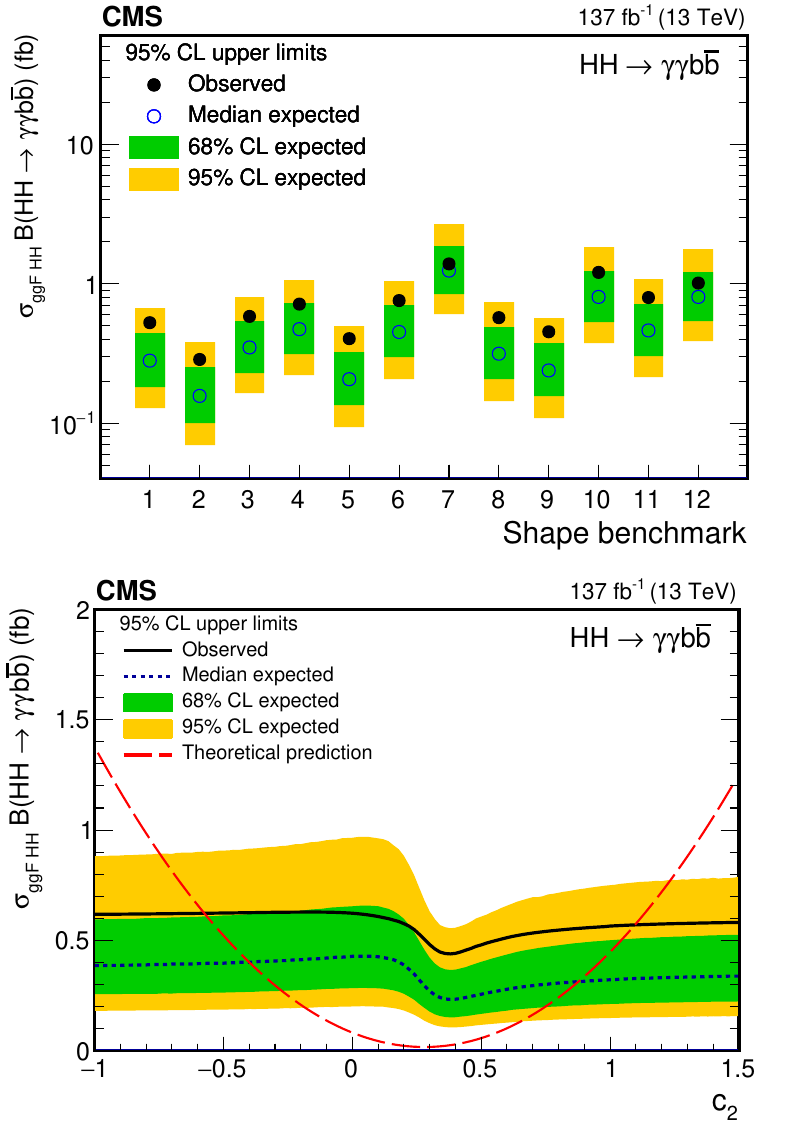
Figure 16 . Expected and observed 95% CL upper limits on the product of the ggF HH production cross section and B (HH → γγ bb) obtained for different nonresonant benchmark models (defined in table 1) (upper) and BSM coupling c (lower). In this fit, the yield of the VBF HH signal 2 is constrained within uncertainties to the one predicted in the SM. The green and yellow bands represent, respectively, the one and two standard deviation extensions beyond the expected limit. On the lower plot the long-dashed red line shows the theoretical